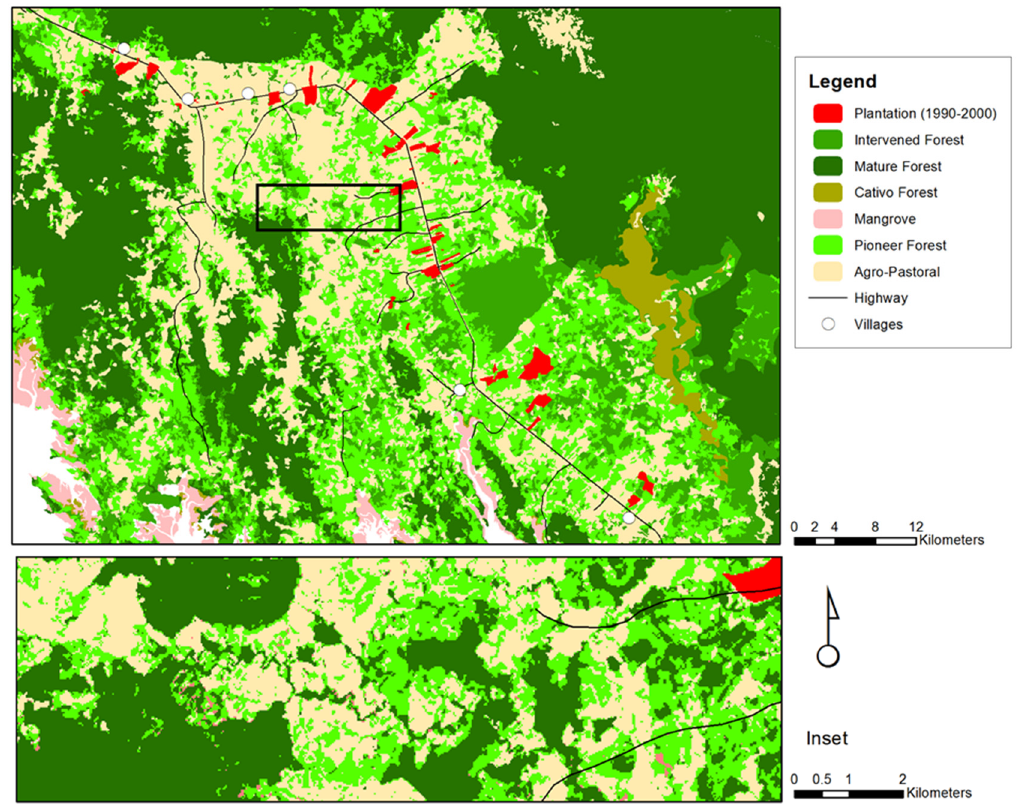
Figure 5. Land Cover in the Bayano-Darién Region, 2000. Source: Insert map after [67].